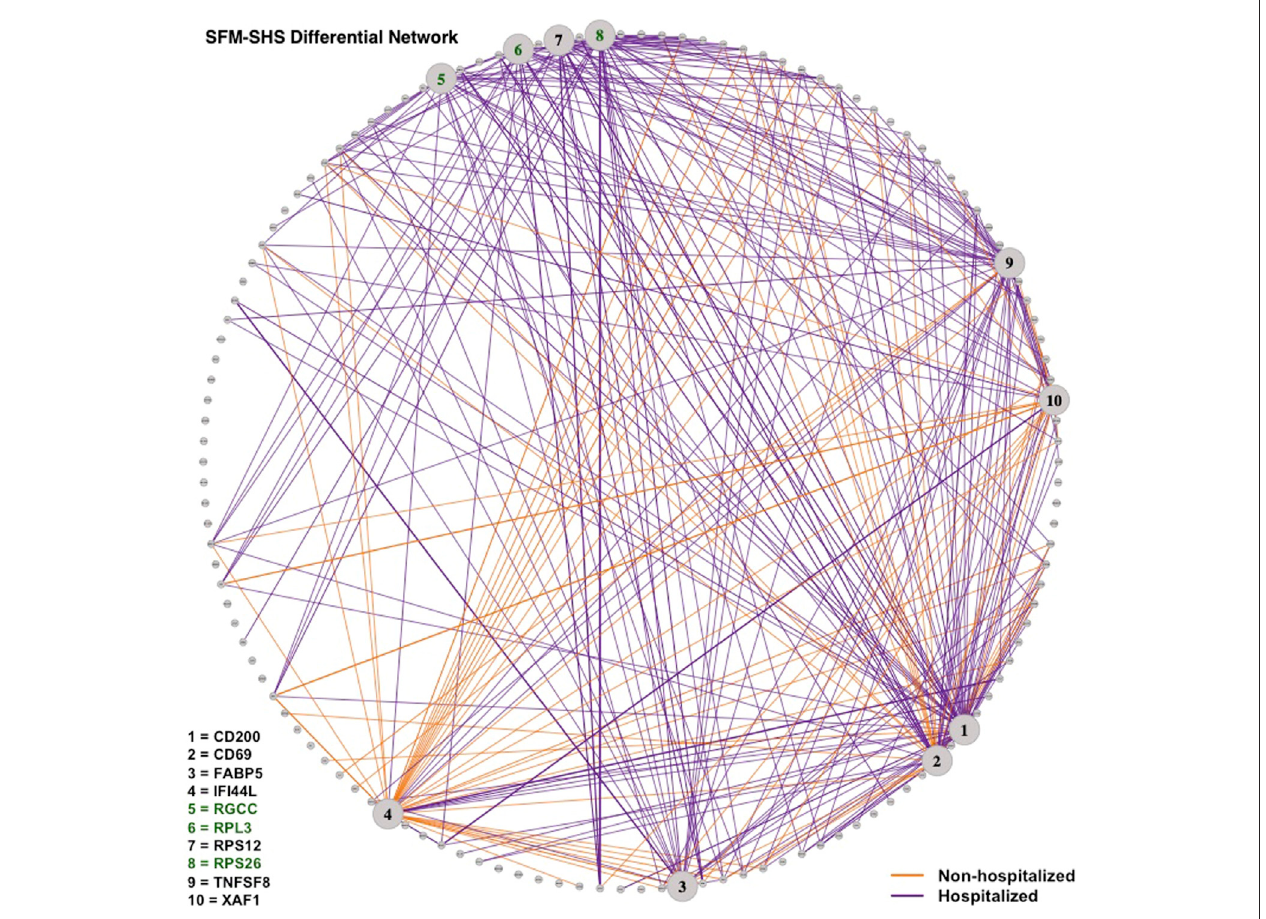
FIGURE6 | Differential networkestimated by SFM-SHS with the bootstrap procedure for the SARS-CoV-2 case study dataset.Edgesdisplayed are for10 DCGs. The 7 unique top DCGs identi fi ed by both SFM-SHS and SFM-DHS are listed in black and the 3 top DCGs identi fi ed by all considered methods are listed in green. Each edge color represents the group with the larger correlation